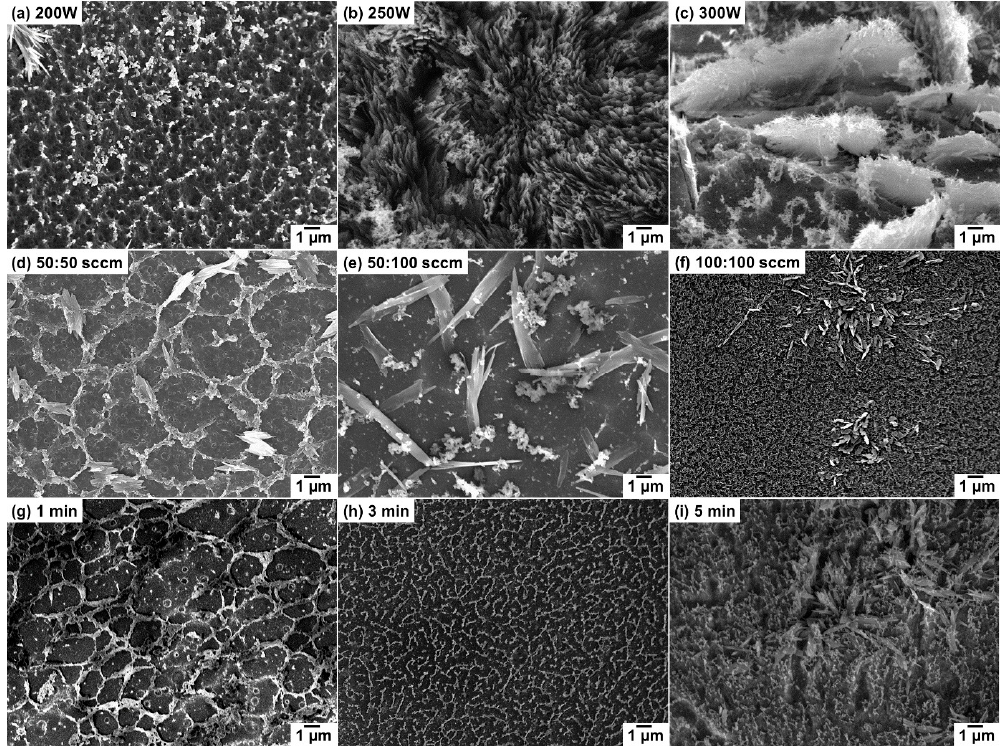
Figure 1. Secondary electrons (SE) SEM micrographs of carbon structures after plasma surface treatment on RF gel at di ff erent treatment conditions: ( a – c ) di ff erent power at 100:50 sccm and 8 min; ( d – f ) di ff erent flowrates at 250 W and 8 min and ( g – i ) di ff erent time at 250 W and 100:50 sccm.